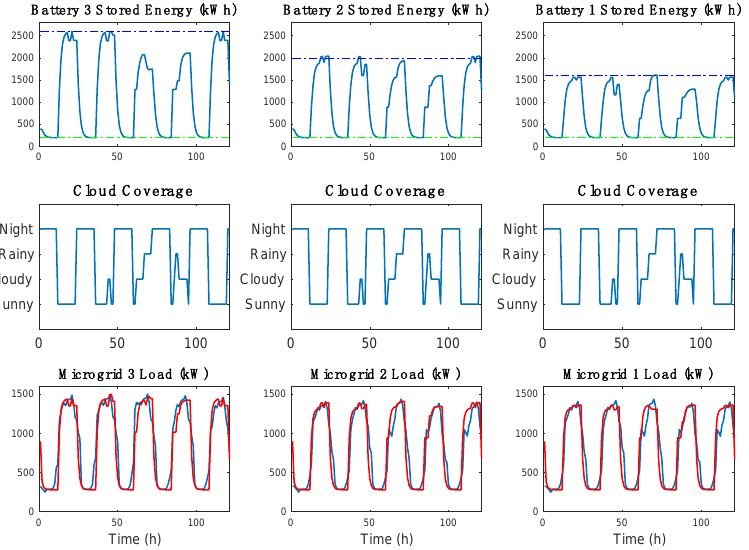
Figure 4. Simulation results when MGs 1–3 are interconnected : battery energy variation (top figure), cloud coverage (middle figure), commercial load (blue) and load power usage (red) (bottom